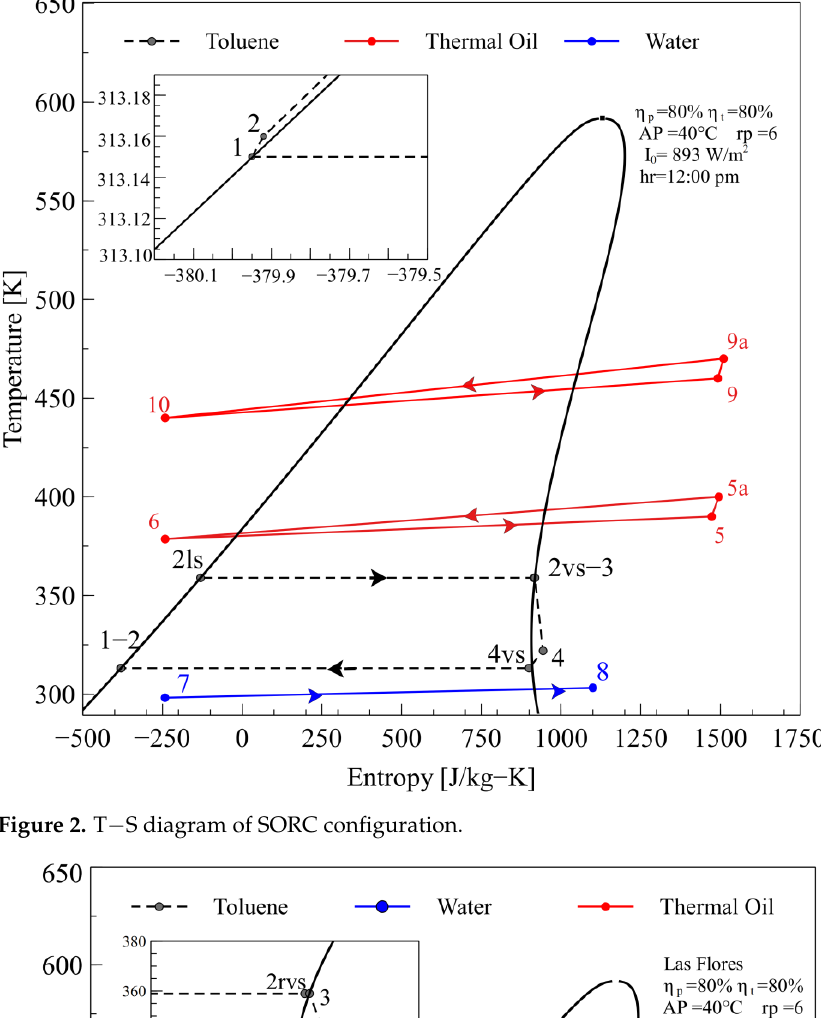
Figure 2. T − S diagram of SORC configuration.